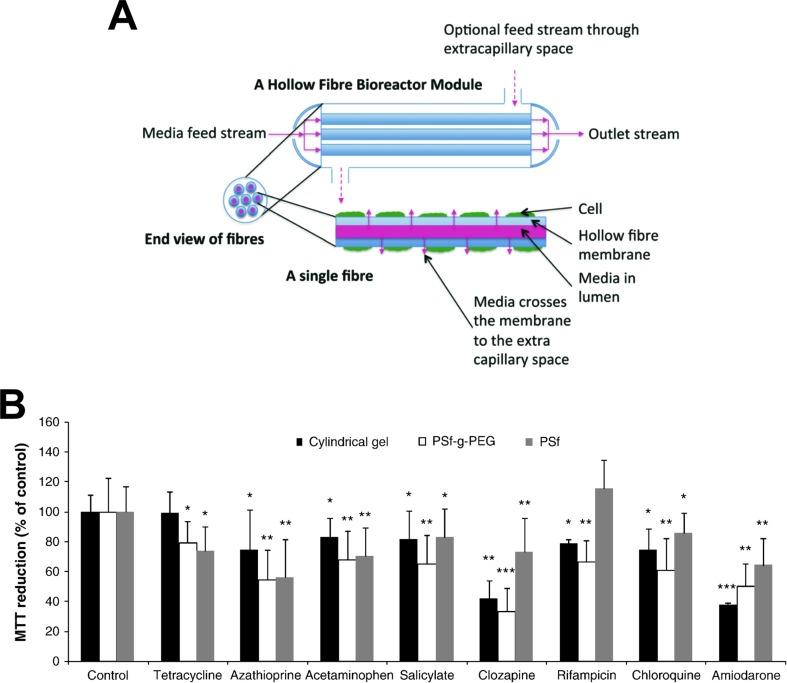
Hollow fiber bioreactors for organotypic hepatocyte culture. (A) Schematic representation of a hollow fiber bioreactor setup. Perfusion capillaries pass through a bioreactor module supplying the cells in the extracapillary space with oxygen and nutrients. (B) Hepatotoxicity of eight drugs was evaluated in bioreactors with hollow fibers made from polysulfone-g-poly(ethylene glycol) (PSf-g-PEG) or polysulfone (PSf) and was compared to cultures in cylindrical gels without hollow fibers. PSf-g-PEG fibers drastically reduced protein absorption and supported cellular functions as well as drug sensitivity. Error bars indicate ± SD; *p < 0.05, **p < 0.01, and ***p < 0.001. Figure modified with permission from (Shen et al., 2010; Williams et al., 2013).